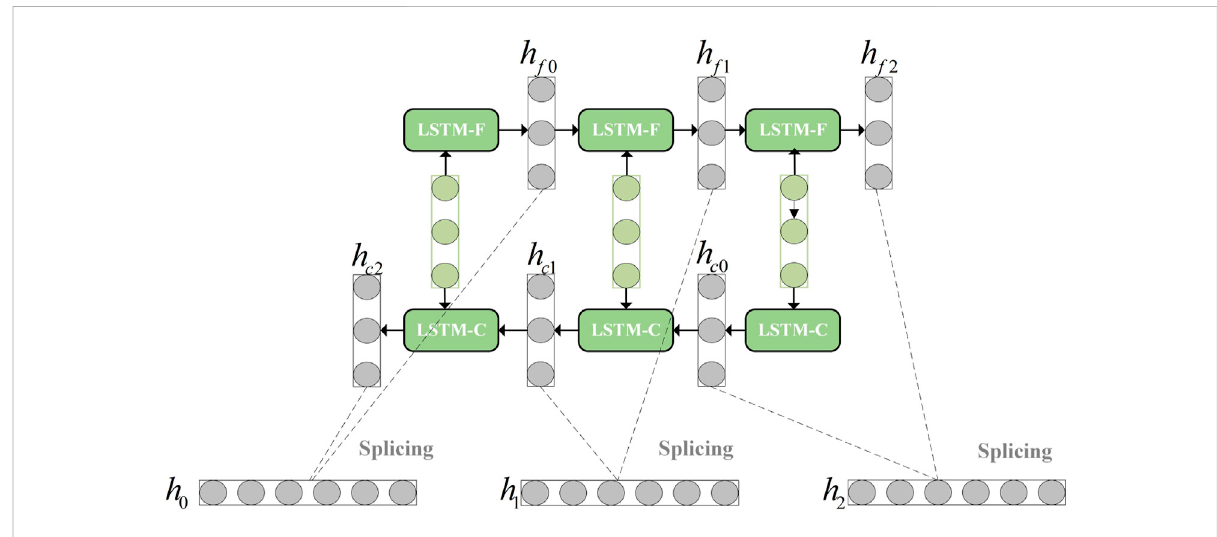
FIGURE 6 BI-LSTM bi-directional conductive splicing combinatorial